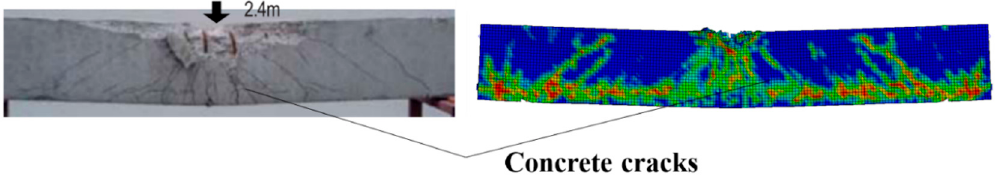
Figure 4. Damage behavior and numerical analysis results of the RC beam under the impact